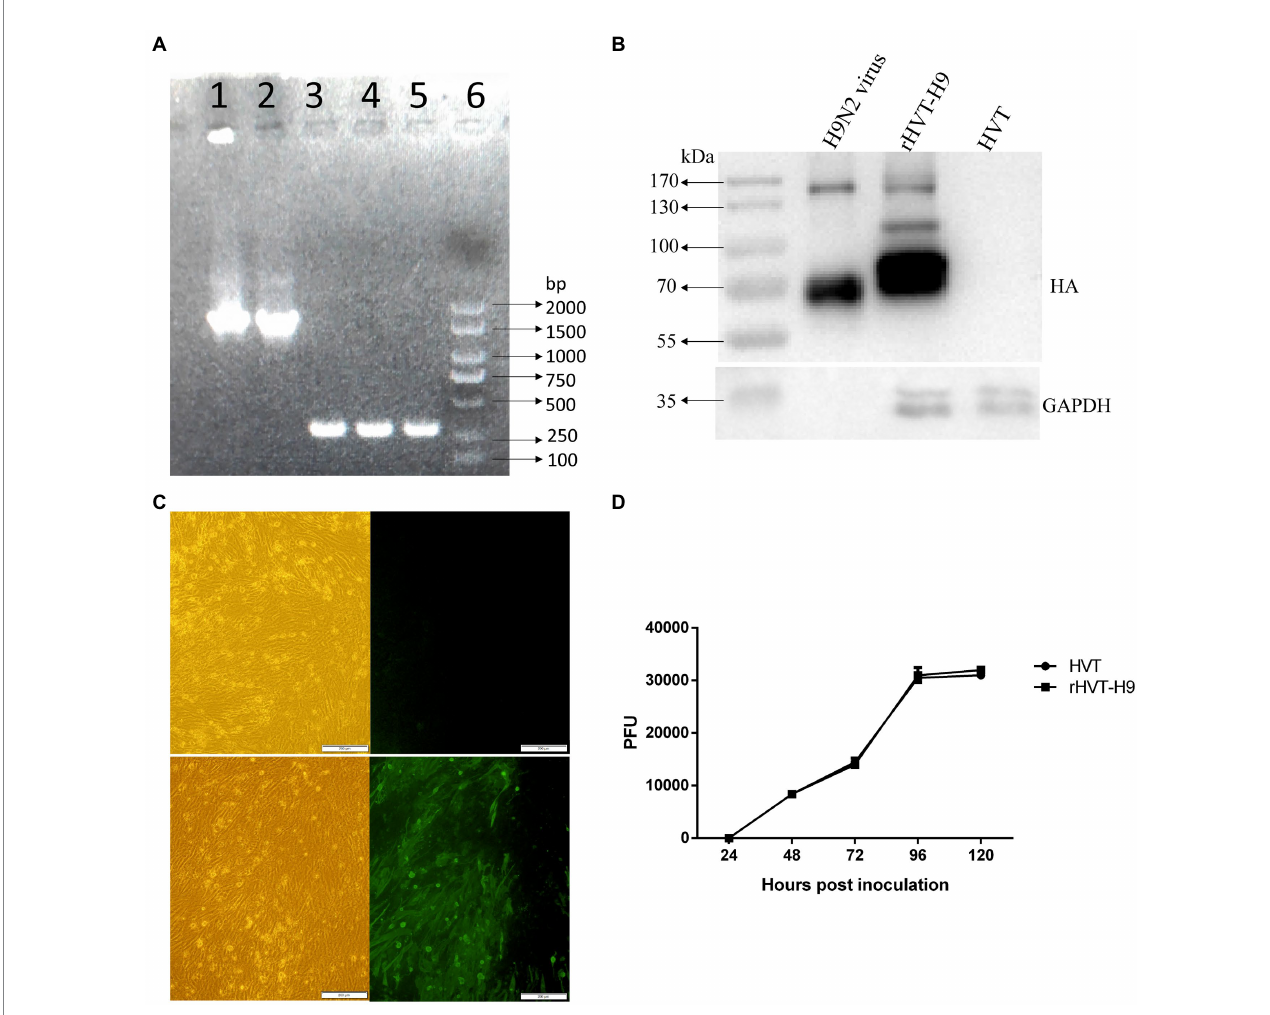
FIGURE 1 Identification of the rHVT-H9 in vitro . (A) Gel electrophoresis of the rHVT-H9. Cytopathic CEFs were harvested to examine whether the rHVT-H9 was generated successfully by gel electrophoresis. Line 1 and 2 were amplified by HA-specific primers from the first and second generation of the rHVT-H9 inoculated cells, respectively. Line 3 and 4 were amplified by HVT-specific primers from the first and second generation of the rHVT-H9 inoculated cells, respectively. Line 5 was amplified by HVT-specific primers from the HVT inoculated cells. Line 6 was Marker 2000. (B) Western blot analysis of the rHVT-H9. CEFs were inoculated with the rHVT-H9 or HVT virus. Cells were harvested to examine HA proteins expressions by western blot at 4 days p.i. H9N2 (H514) virus collected from embryonated chicken eggs was served as positive control. (C) IFA detection of the rHVT-H9. CEFs were inoculated with the rHVT-H9 or HVT as control. Cells were harvested to examine HA proteins expressions by IFA at 4 days p.i. The results were observed by using inverse microscopy (magnifications 100×). The upper was observed on HVT inoculated CEFs; the lower was observed on rHVT-H9 inoculated CEFs. The left was in white light and the right was in blue light (D) Growth curve of the rHVT-H9. CEFs were inoculated with the rHVT-H9 or HVT virus with 0.01 MOI. Cells were harvested and titrated at 24, 48, 72, 96 and 120 h p.i. The error bars indicate standard